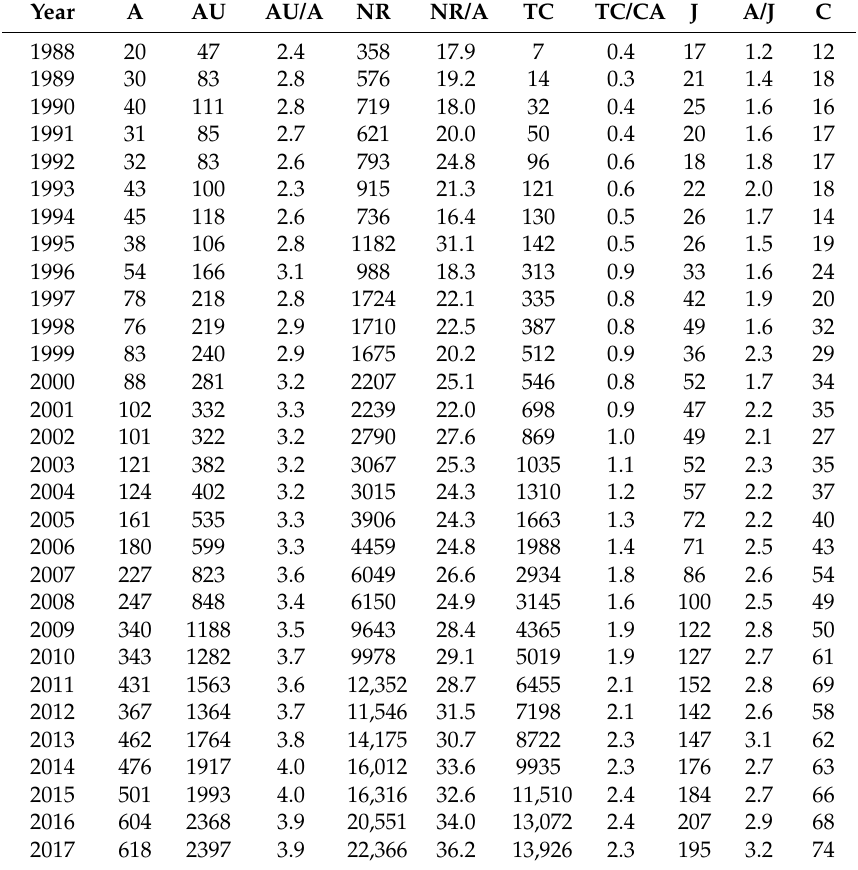
Table 1. Major characteristics of the articles on Water Use Efficiency in Agriculture (WUEA) research from 1988 to